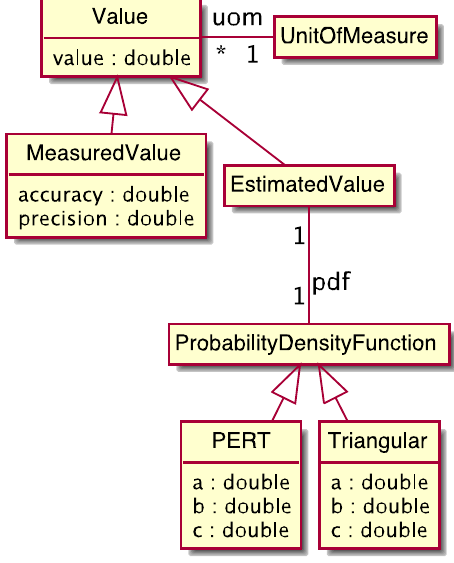
Figure 1. Proposed extension of the Value class.